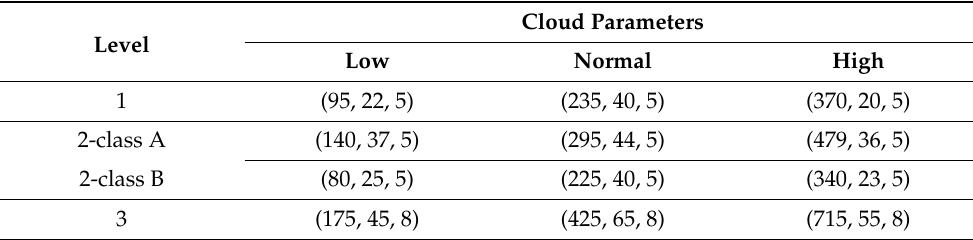
Table 13. Evaluation level of the normal cloud